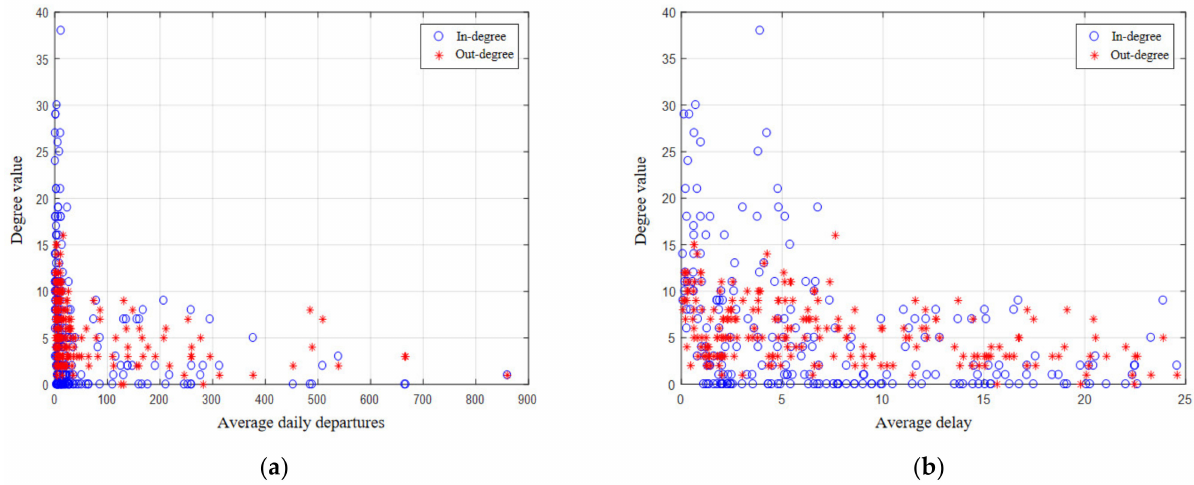
Figure 18. Relationship between 20 degrees and departure flight volume and average delay